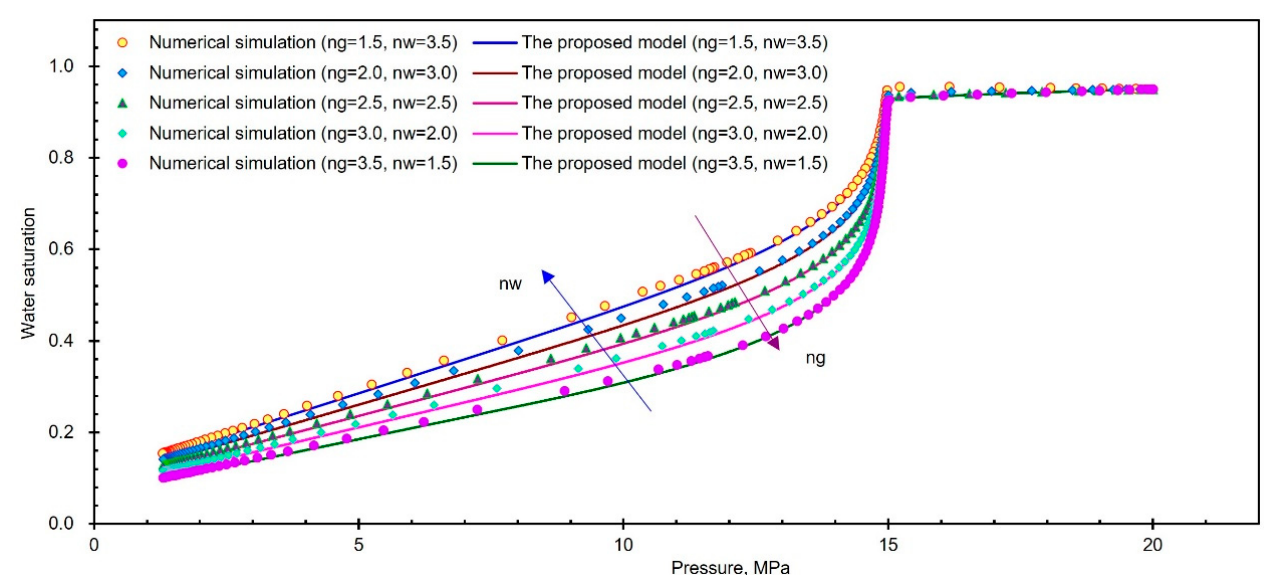
Figure 8. Comparison of calculation results of the proposed method considering different gas–water relative permeability curves.